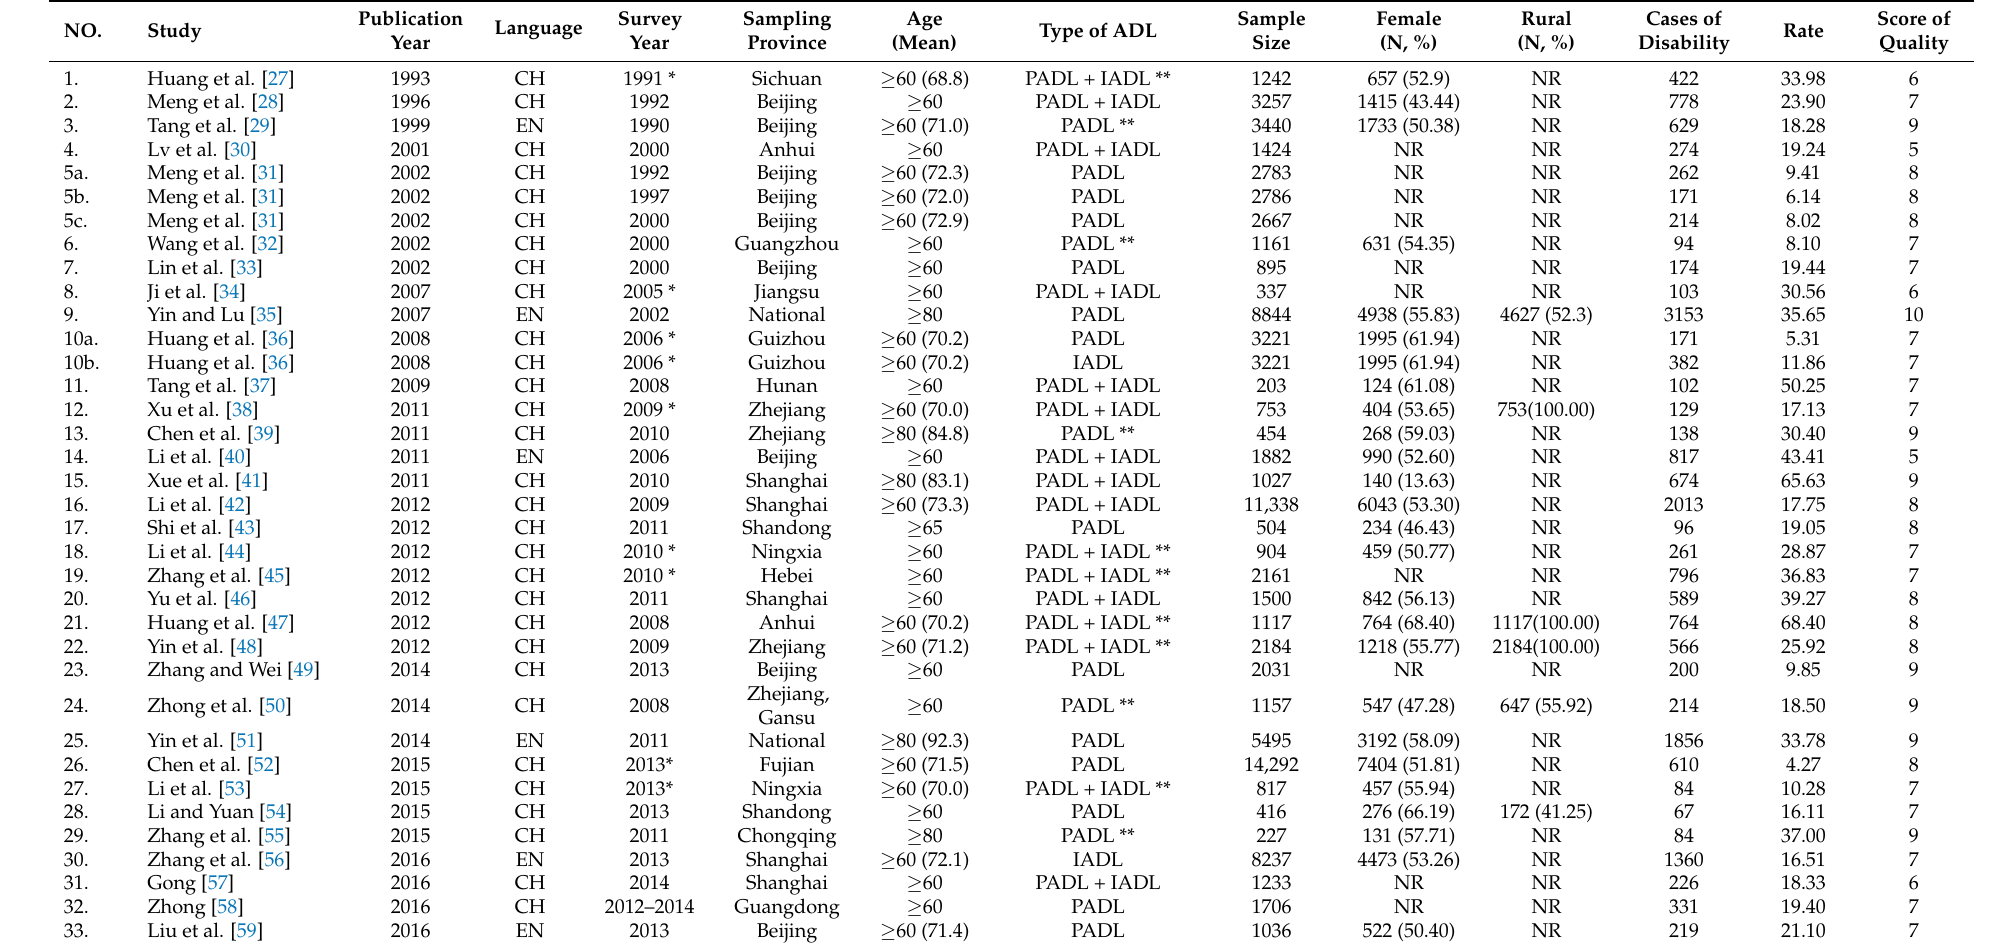
Table A1. Characteristics of the 97 studies included in the